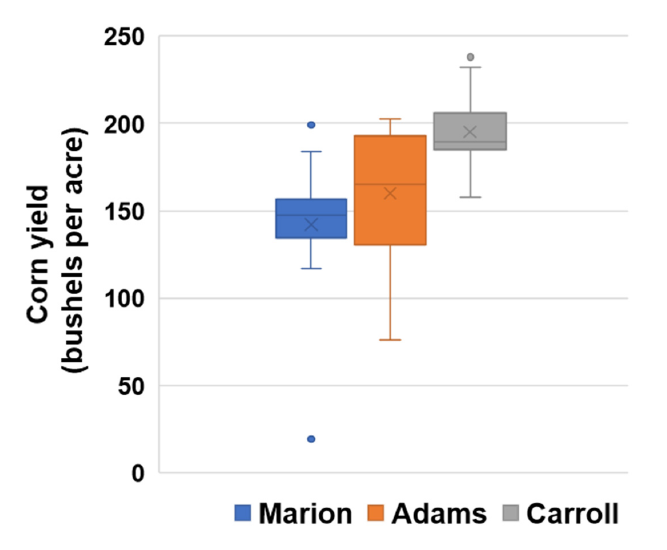
Figure 9. Time-series of ( a ) 𝑆𝐼 (cid:3017)(cid:3006)(cid:3021)(cid:2871) , ( b ) 𝑆𝐼 (cid:3020)(cid:3014)(cid:2871) , and ( c ) 𝑆𝐼 (cid:3006)(cid:3023)(cid:3010)(cid:2871) in Effingham and Marion in 2006.